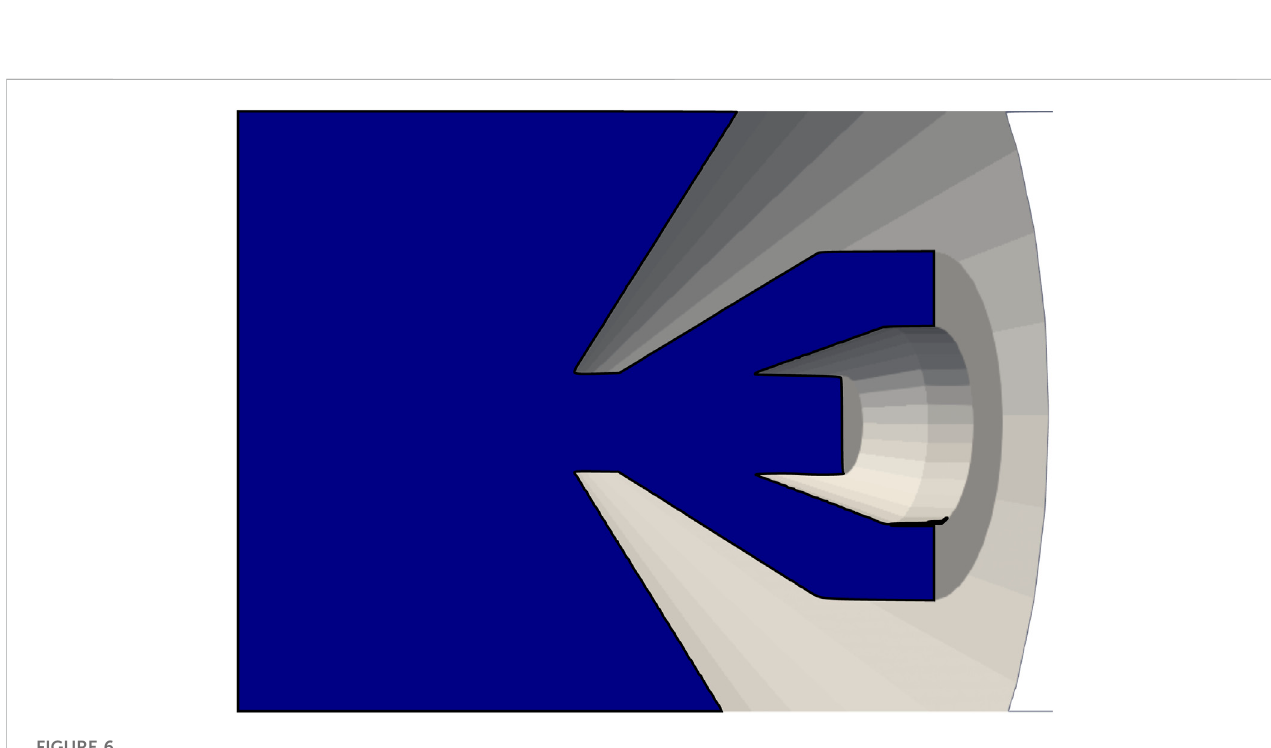
FIGURE 6 Computational fl ow fi eld region for the GDVN with cone-shaped geometry for the gas fl ow fi